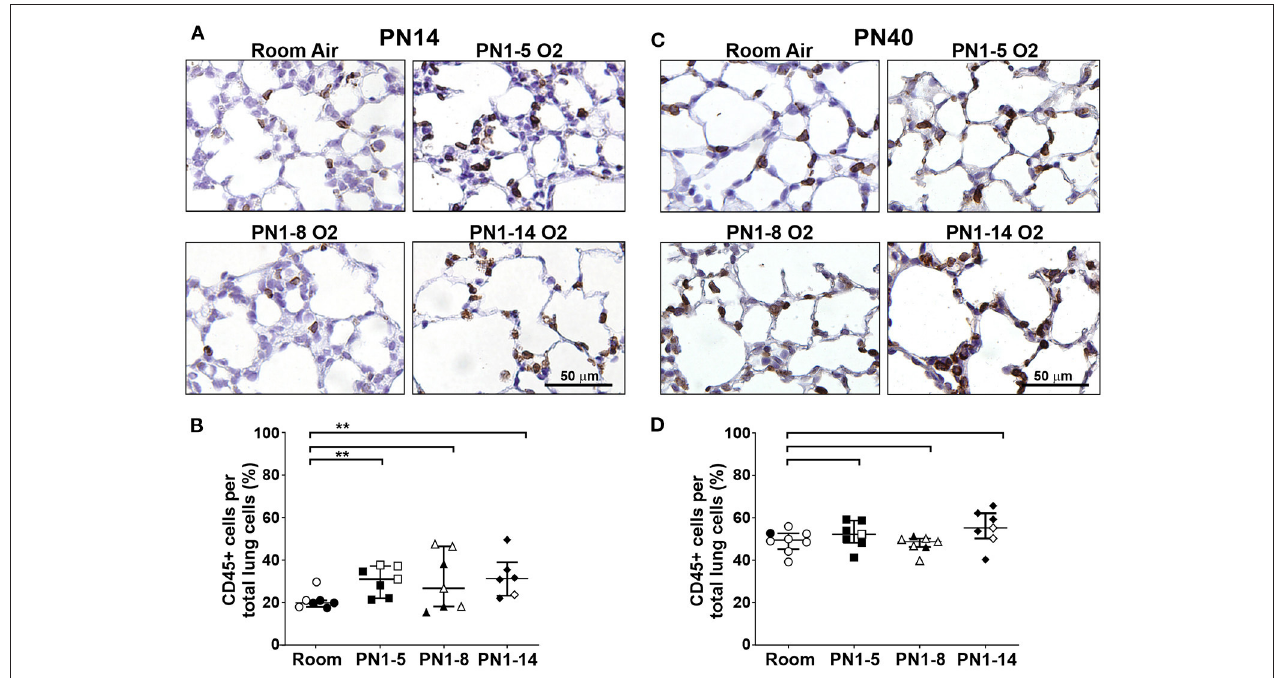
FIGURE 4 | Inflammation is present in the lungs of neonatal mice exposed at birth to supplemental oxygen but is moderated in young adult mice. C57BL/6 mice were housed in room air or treated from the day of birth with 75% O 2 for 5, 8, or 14 days, then their lungs were analyzed at PN14 (A,B) or PN40 (C,D) by staining with the pan-leukocyte cell surface marker CD45. (A) Representative images of lung paraffin sections stained at PN14, and (B) quantitation of the proportion of CD45 + immune cells per total alveolar cells. (C) Representative images of lung paraffin sections stained at PN40, and (D) quantitation of the proportion of CD45 + immune cells per total alveolar cells. In (A,C) , sections were counter-stained with hematoxylin and CD45 + cells are indicated by brown staining; scale bar = 50 µ m. Note that lungs were not perfused or flushed prior to fixation and extraction. Images were taken with 40x objective using an Olympus BX-51 bright field microscope. Data in (B,D) is presented as median ± IQR. ** P < 0.01 by Mann-Whitney U -test (2-tailed). n ≥ 6 mice per group, with 1–2L used for analysis of each oxygen group in (A,B) , and 2–3L used for analysis of each oxygen group in (C,D) . Gender is represented by closed (male) and open symbols (female). PN,